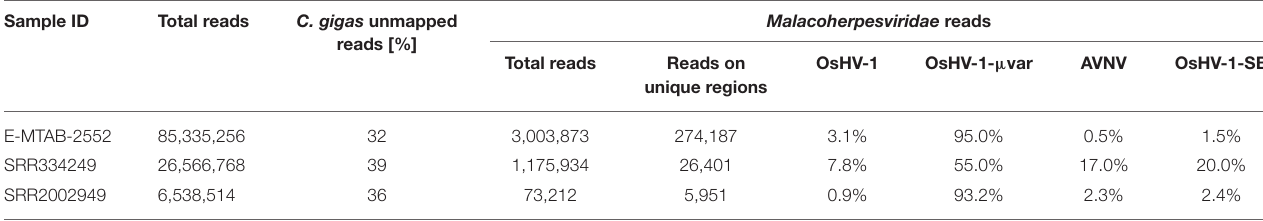
From left to right: sample ID, total number of reads, percentage of C. gigas genomic unmapped reads and, for Malacoherpesviridae, the table illustrates the total number and fraction of reads mapped on unique regions of four viral genomes, with the assignment of percentages to each individual virus.